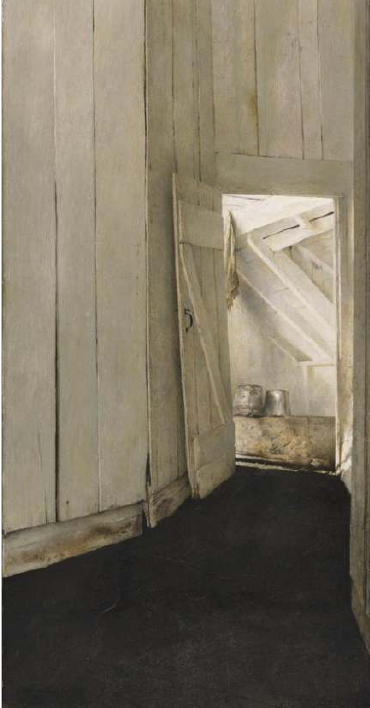
Figure 14. Andrew Wyeth, Cooling Shed . Tempera on panel